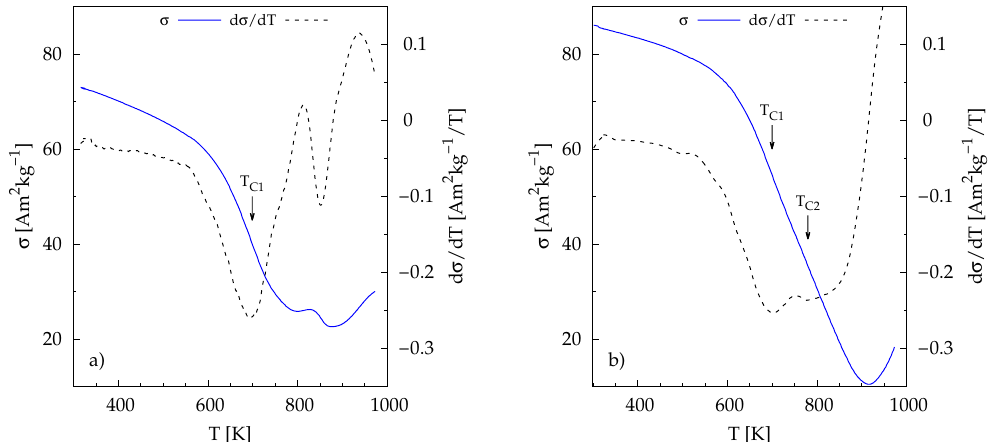
Figure 11. Temperature dependence of magnetization σ ( T ) for ( a ) CoFeTaB and ( b ) CoFeWB alloys after 100h of milling. Dashed lines show the respective temperature derivative of magnetization, d σ / dT . Vertical arrows depict the possible magnetic transition with corresponding Curie